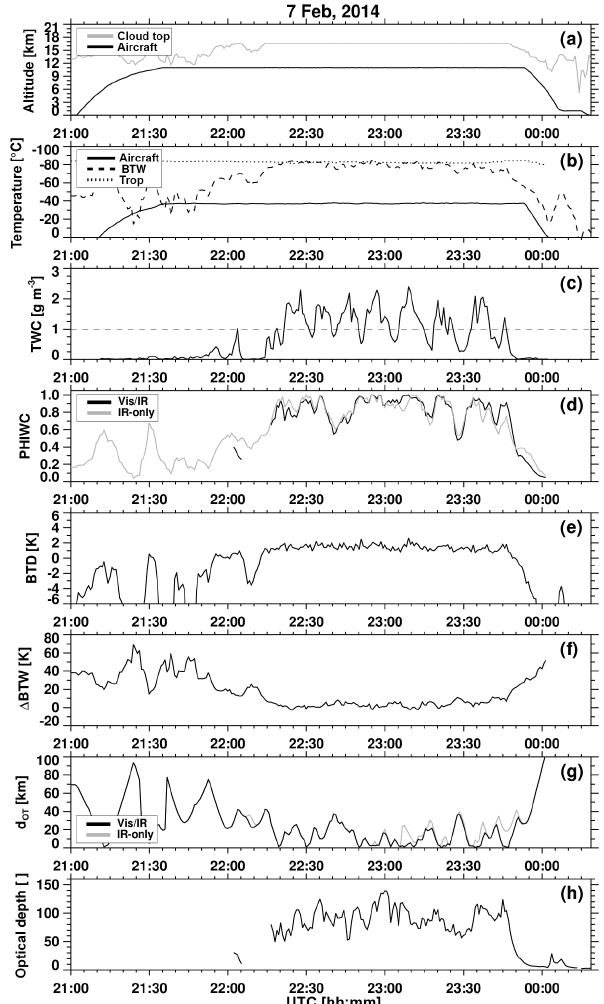
Figure 8. Time series of matched aircraft and satellite observations for Flight 16 of Darwin-2014 on 7–8 February 2014. The panels are the same as those described for Fig.